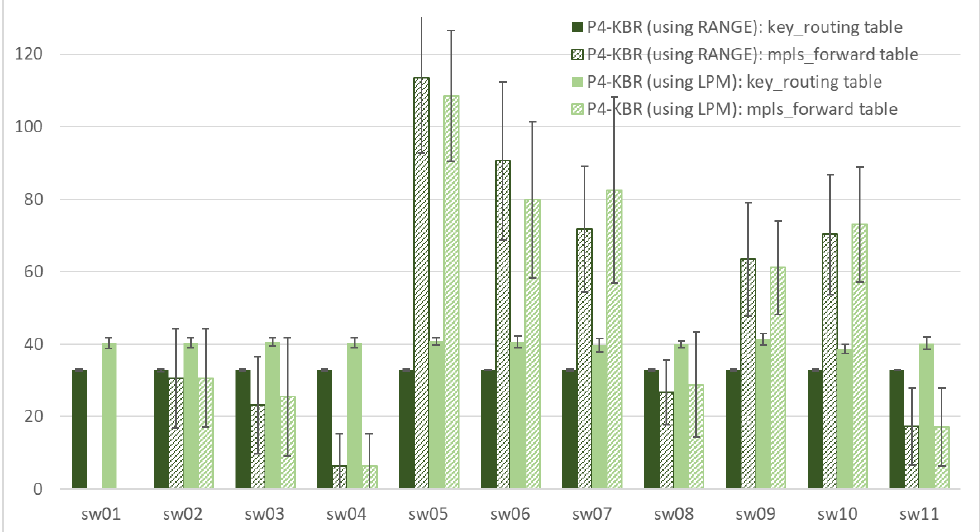
Figure 11. P4-KBR system. Occupacy of the device tables: number of entries in the key_routing and mpls_forwarding